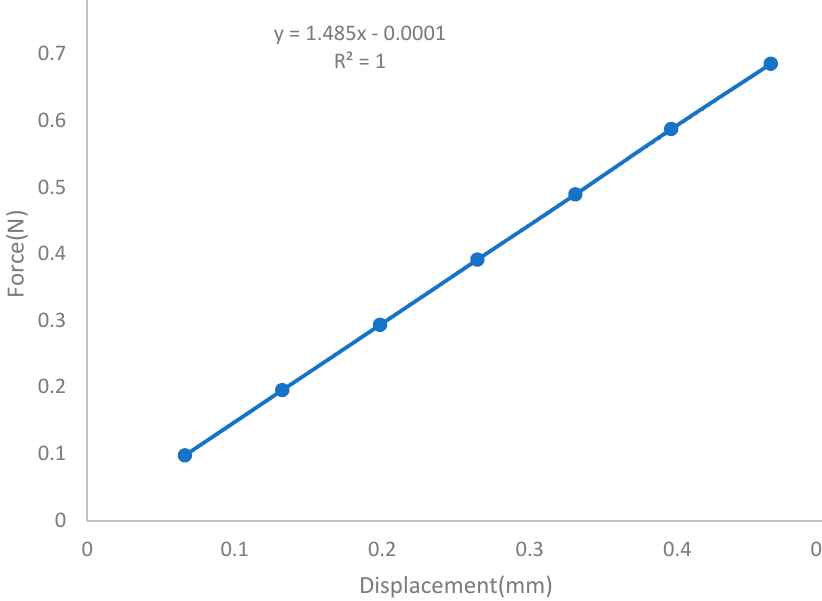
y = 1.485x - 0.0001 R² = 1